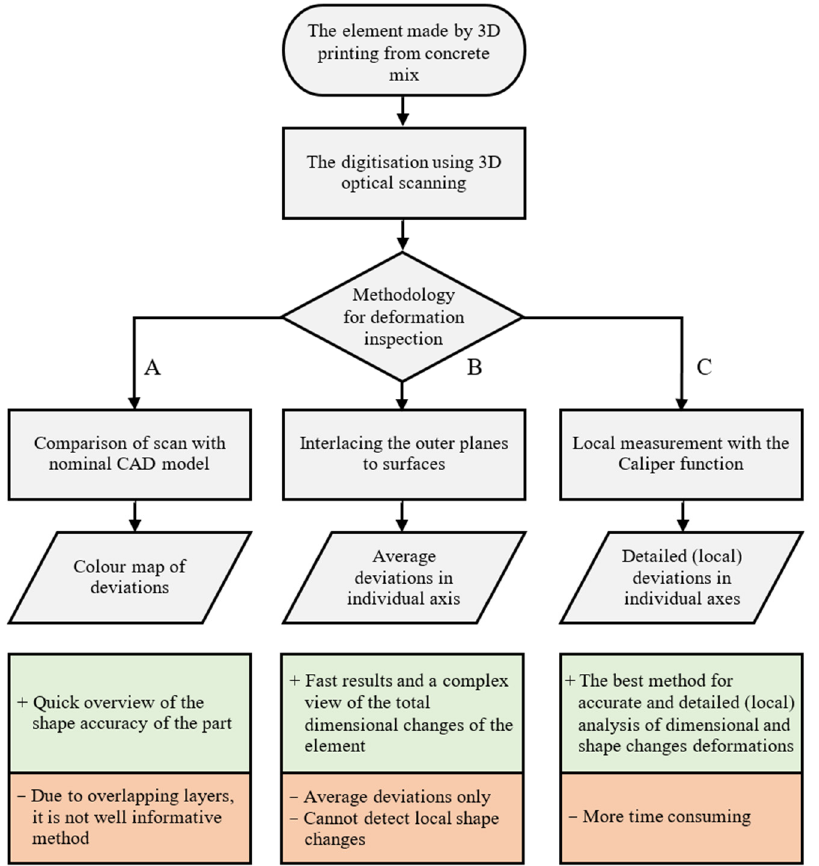
Figure 18. Flow chart of research into a suitable inspection methodology of an element produced by 3D printing from a concrete mix.